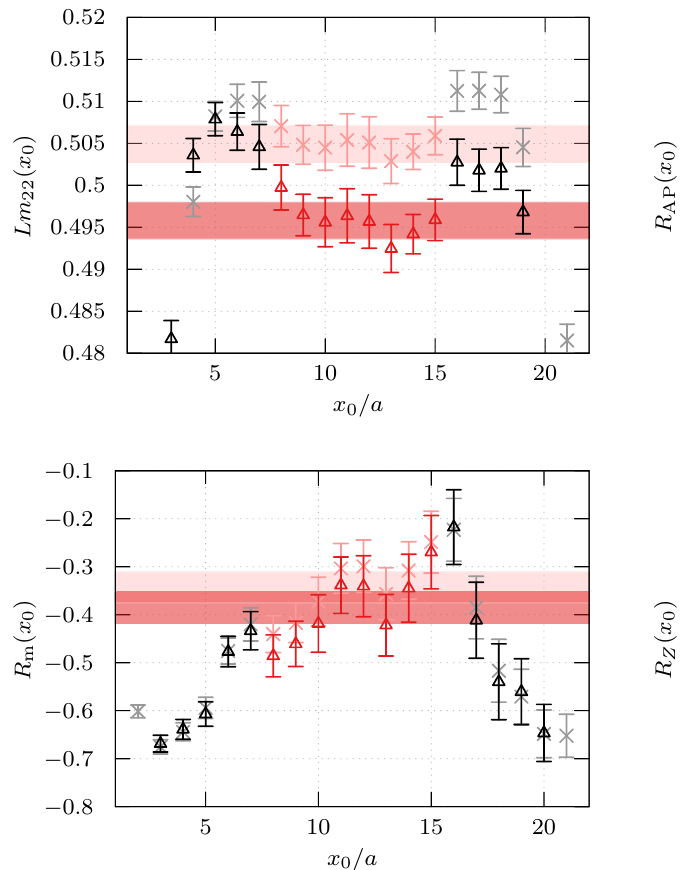
from standard derivatives, while the data points in the foreground with darker colours (triangles) are derived from improved lattice derivatives. Other panels: the x 0 -dependence of the estimators R AP , R m and R Z , and the associated plateau